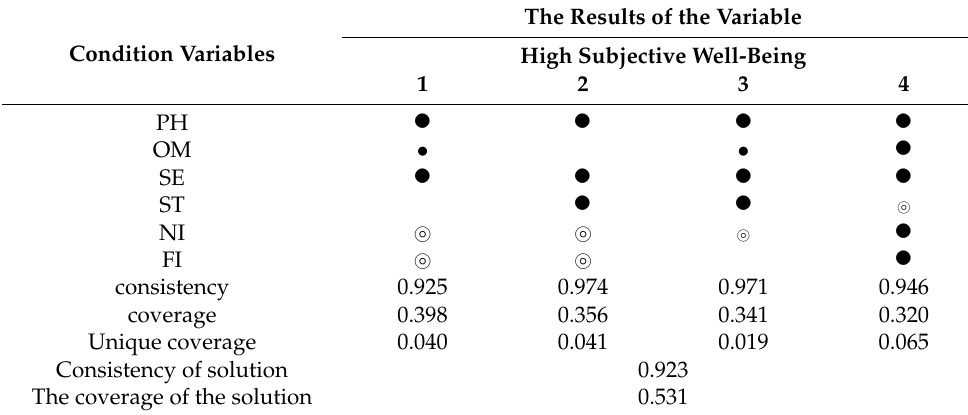
Table 4. Configuration of high subjective